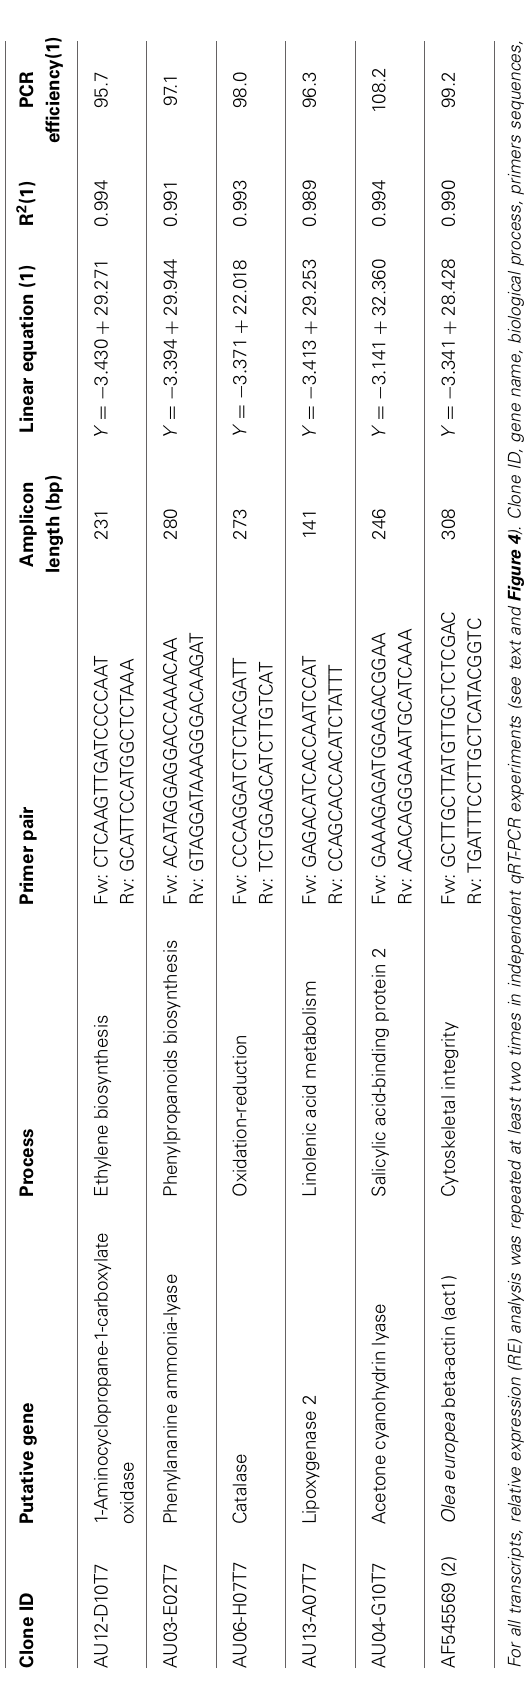
equations, correlation coefficients ( R 2 ) and reaction